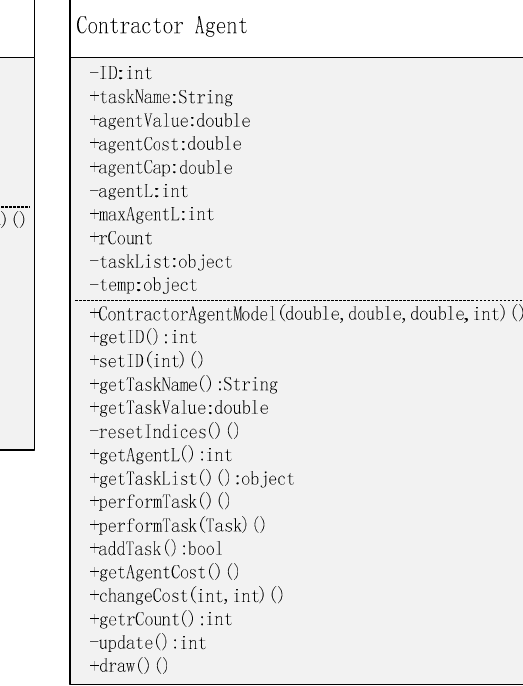
Figure 4. Unified Modeling Language (UML) class diagram of manager agent and contractor agent.